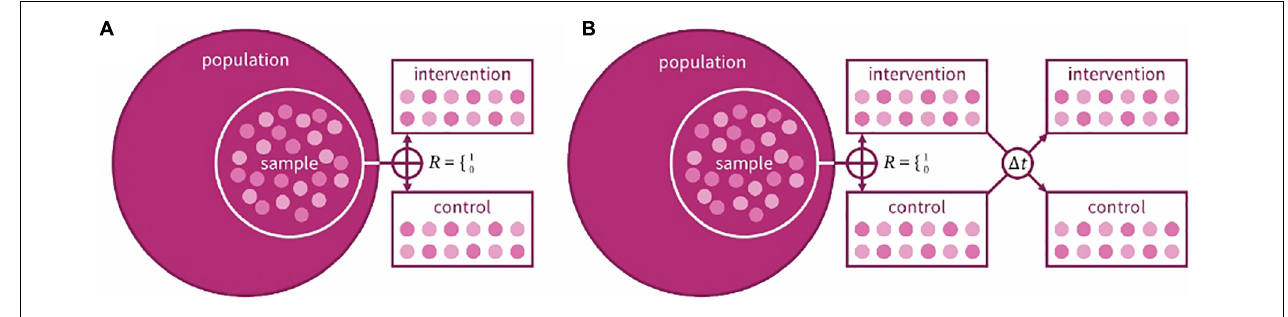
FIGURE 1 | Schematic example of a (A) parallel and (B) crossover design for a two-arm clinical trial. In both designs, a sample is taken from the target population, randomly allocated to intervention or control group. In the crossover design, the same participants are then given the other intervention after an interim washout period